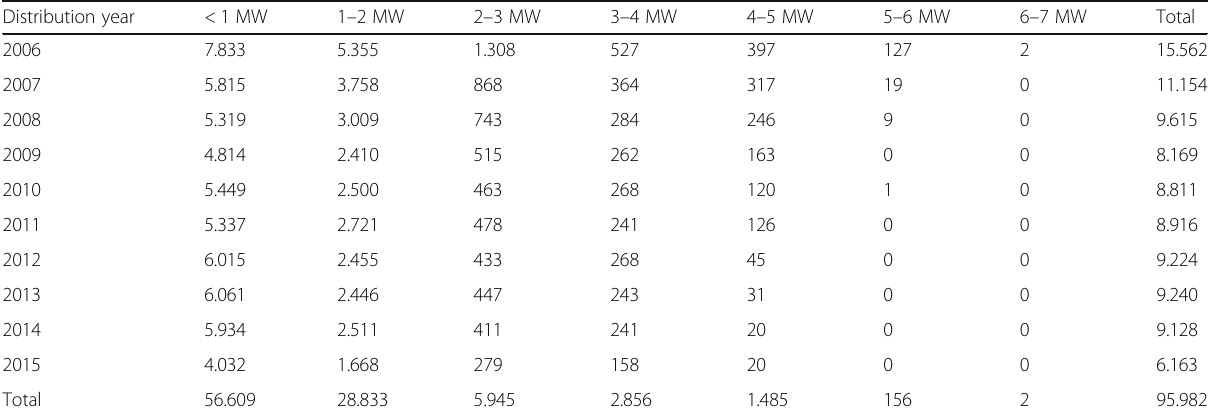
Table 3 Distribution of disability benefits for M79 (and variants) by salary range in minimum wages (MW) from 2006 to 2015 Distribution year